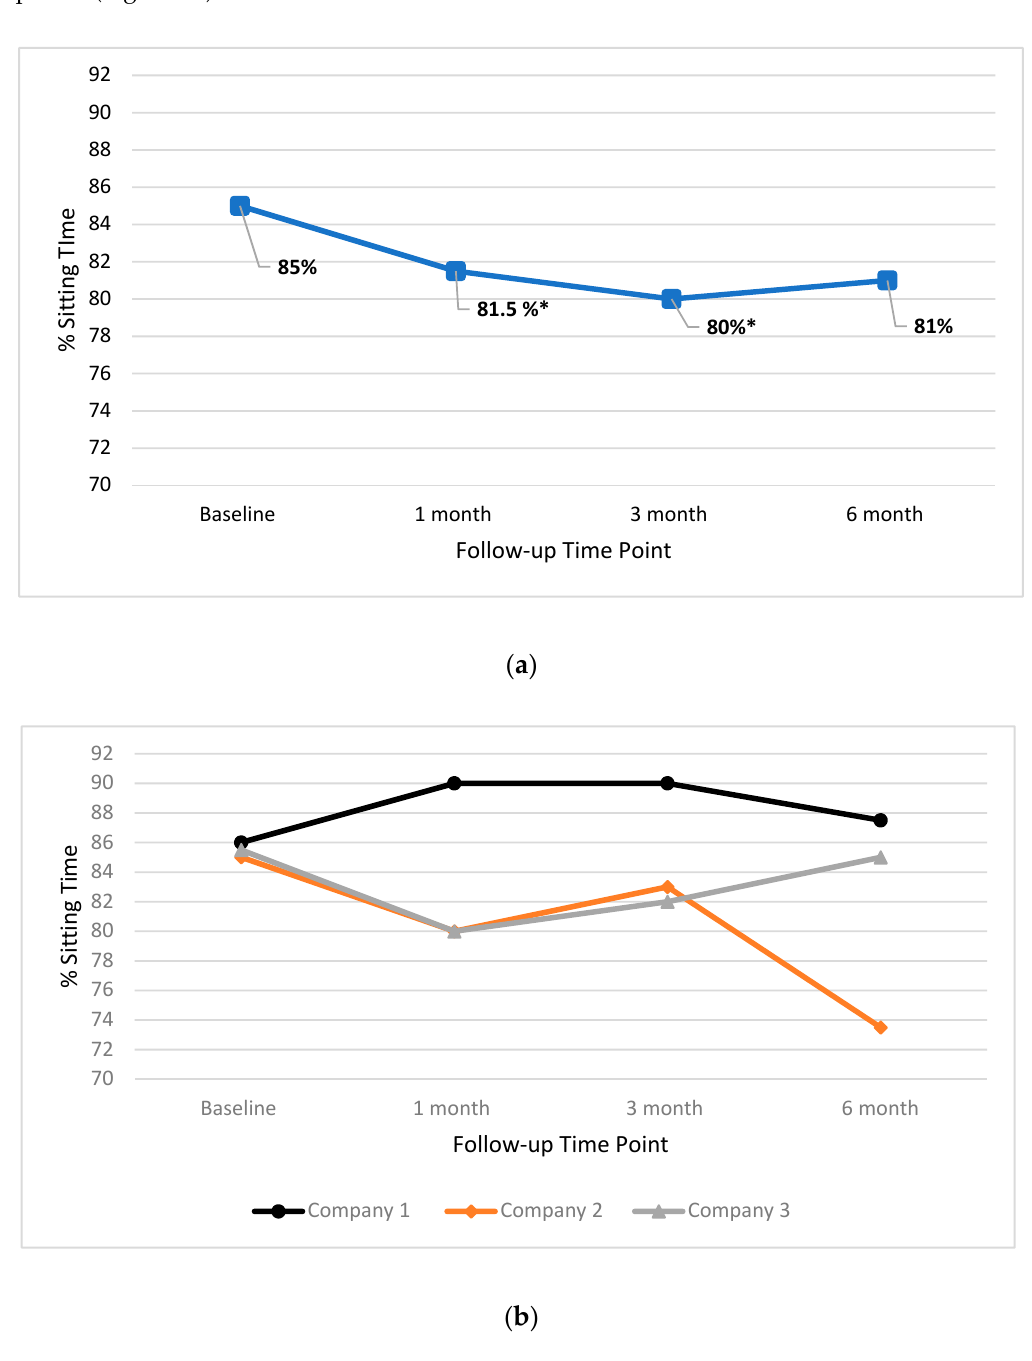
Figure 2. Median percentage workplace sitting time for the total group ( a ) and individual companies ( b ) at baseline, one month, three month and six month time points. * = trend towards significant